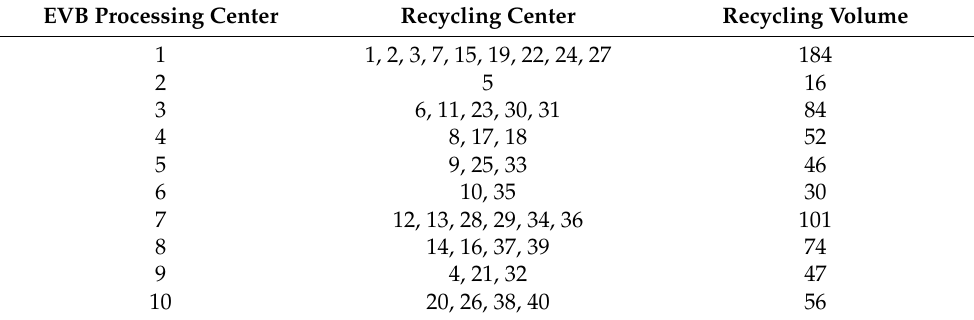
Table 5. Initial clustering results.